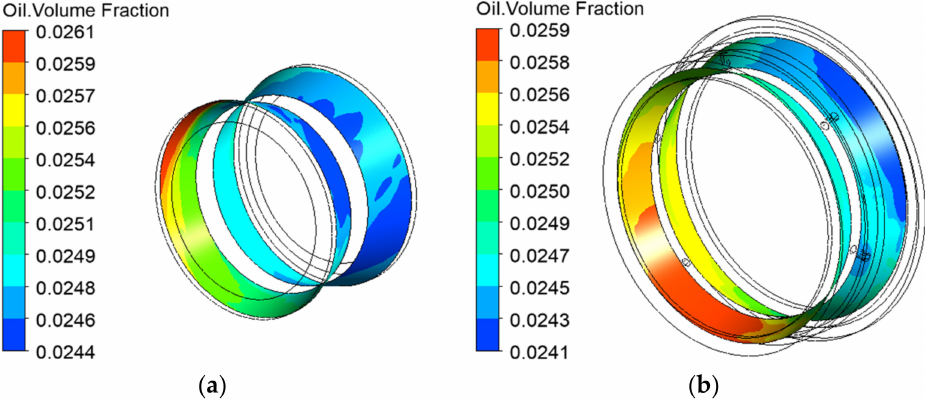
Figure 17. Oil volume fraction of raceways: ( a ) inner ring; ( b ) outer